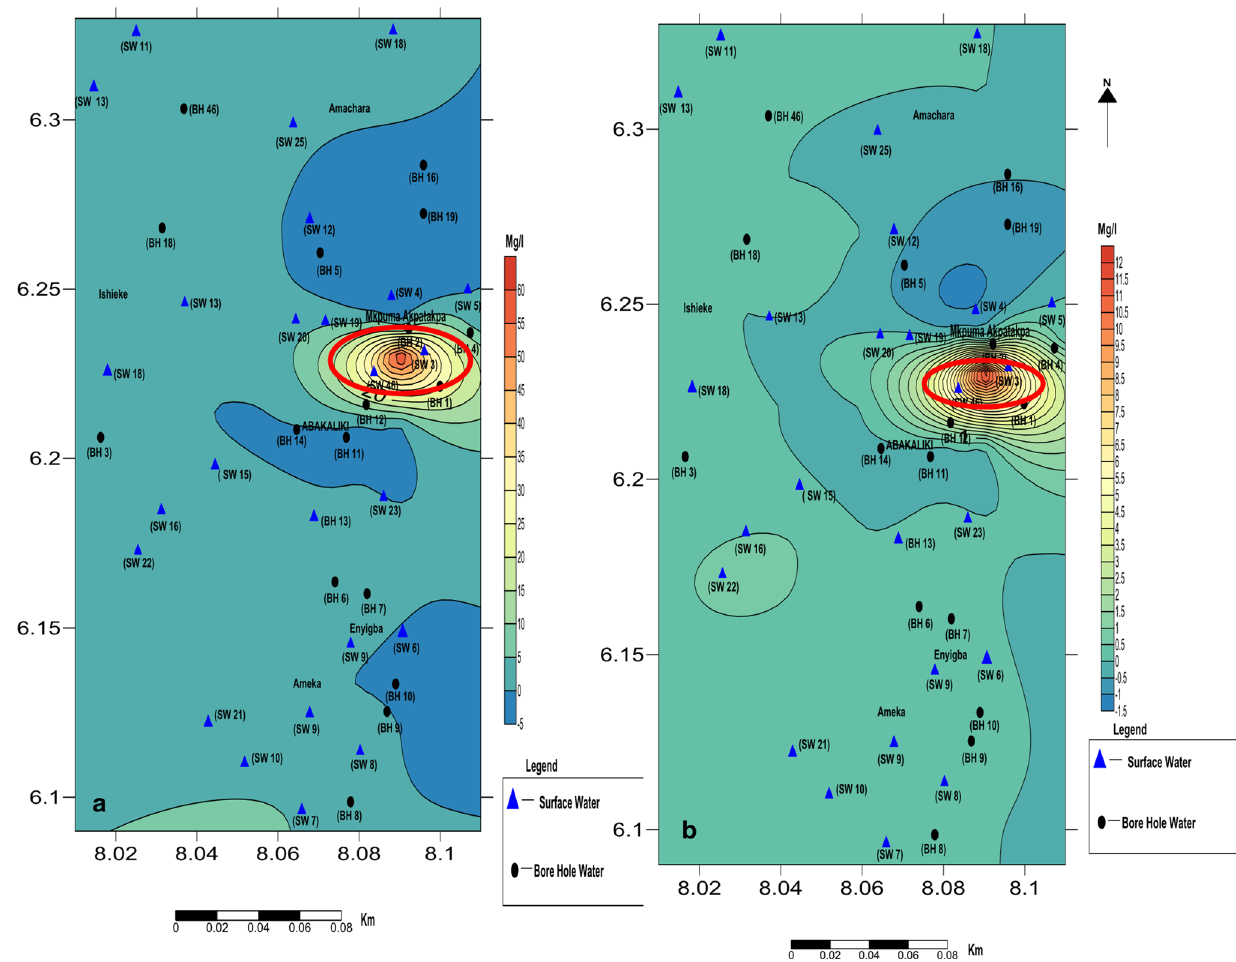
Fig. 4 Distribution of a manganese, b cadmium with potentially high risk areas (as highlighted in red